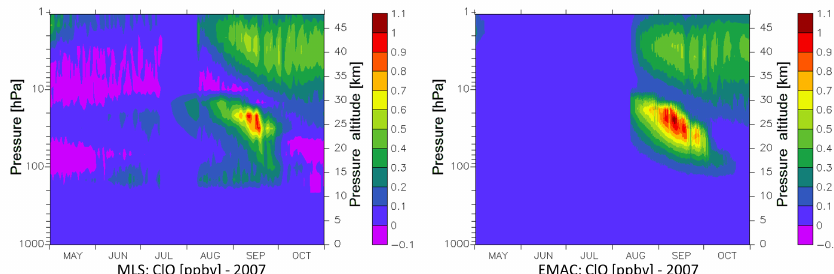
Figure 4. Comparison of ClO from EMAC with MLS observations – time series of ClO in ppbv from MLS (left) and from the standard EMAC simulation (right) during Antarctic winter and spring of 2007 in 79.5 ◦